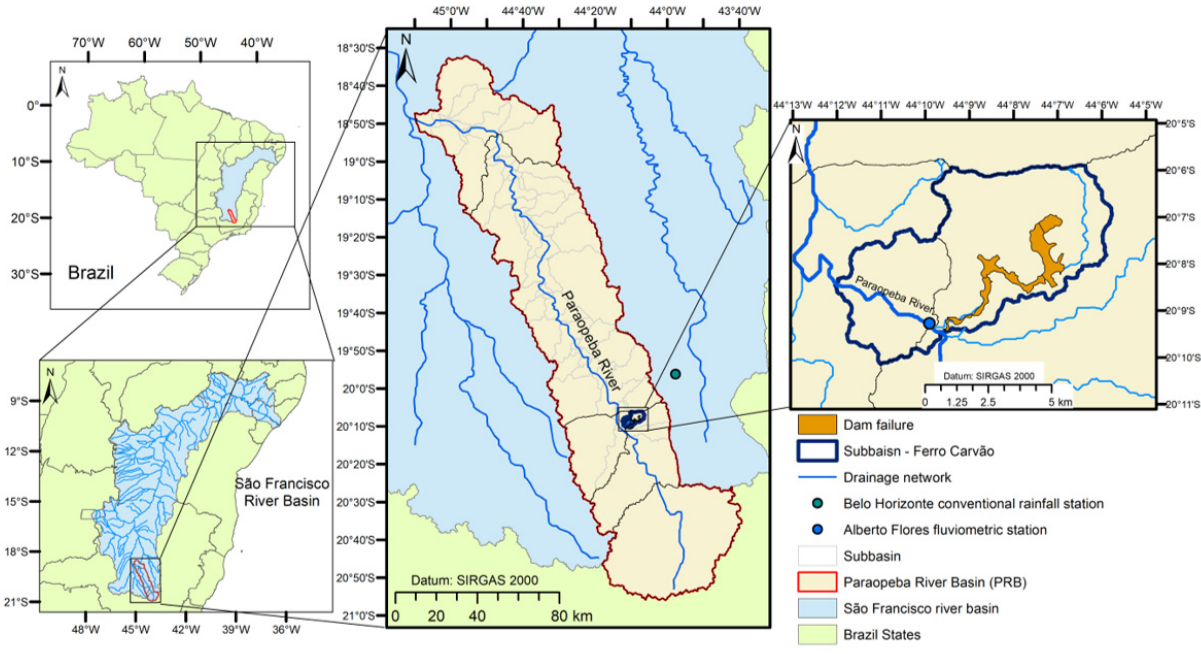
Figure 1. Location of the dam failure area in the Paraopeba River Basin, State of Minas Gerais, São Francisco River Basin, Brazil.